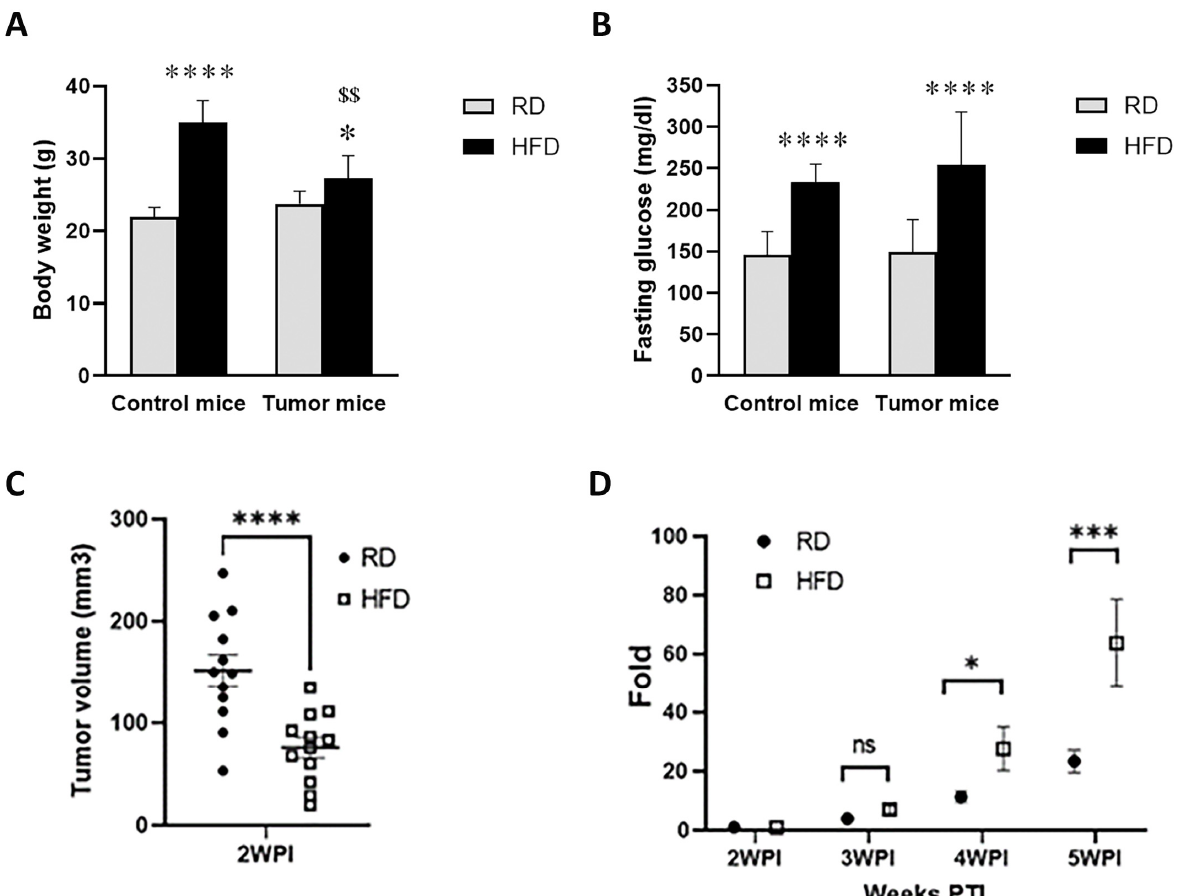
Figure 3. Effect of RD and HFD on body weight, fasting plasma glucose, and tumorigenesis. Bar graphs showing body weights ( A ) and fasting plasma glucose levels ( B ) of RD- and HFD-fed tumor bearing mice (5 wpi) and age-matched control mice at 5 wpi. The error bars represent the standard error of the mean. * p ≤ 0.05 and **** p ≤ 0.0001 between RD and HFD groups. $$ p ≤ 0.01 with respect to control mice. Short-term feeding on RD and HFD differently regulates the early onset of ( C ) tumorigenesis and ( D ) tumor progression in young E0771 syngeneic BC mice (n = 16/group). C57BL/6J (female, 4 weeks old) mice fed a RD or HFD for 4 weeks prior to tumor implantation were continued on the appropriate diet. ( C ) RD tumors were significantly larger compared to HFD tumors at 2 wpi. ( D ) HFD showed significantly increased tumor growth after 3 wpi compared to RD. Graph shows significant fold increase in tumor volume in HFD mice compared to RD mice between 2 and 5 wpi. Y -axis shows fold change in tumor volume compared to tumor volume at 2 wpi. Data represents mean +/ − SEM fold change in tumor volume at different wpi. ns – not significant, * p < 0.05, *** p ≤ 0.001 and **** p < 0.0001.